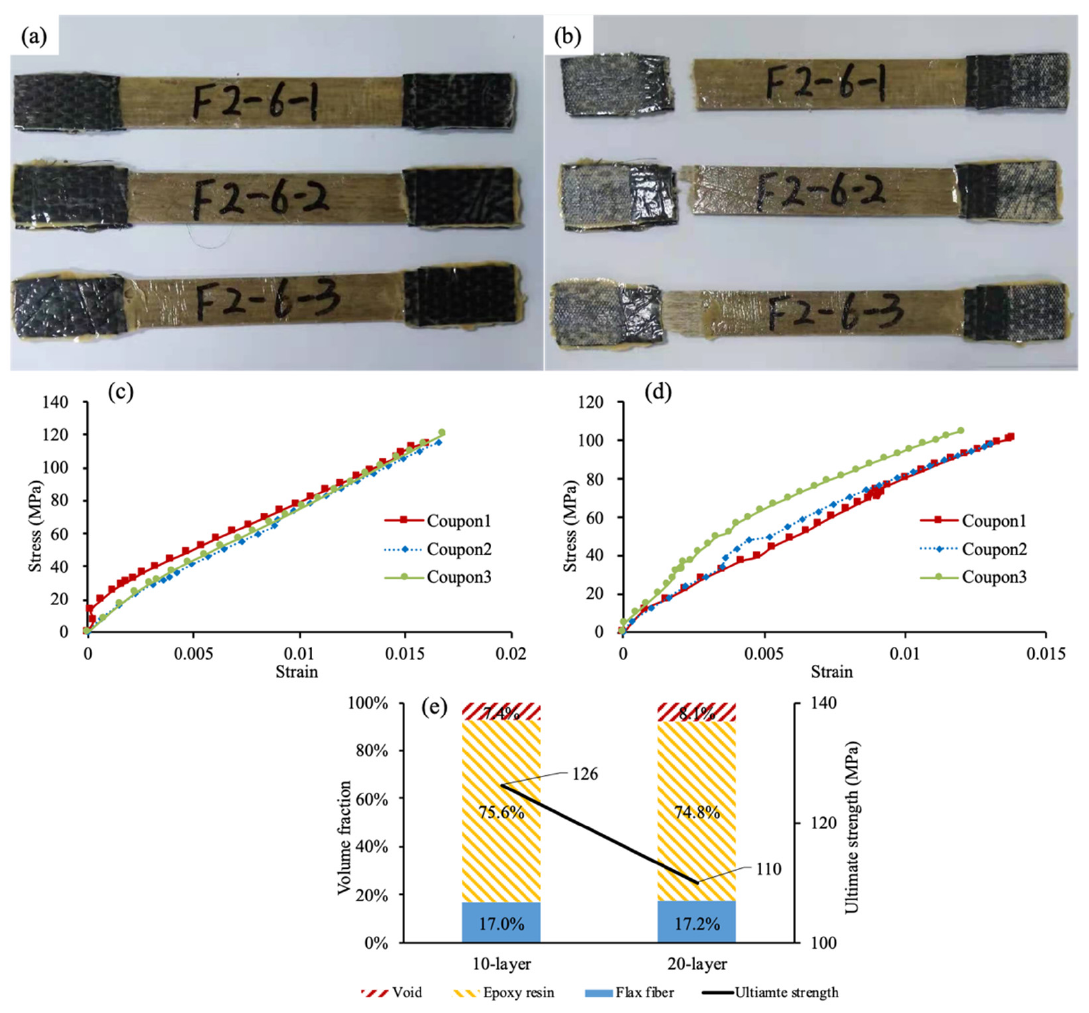
Figure 4. FFRP material properties: ( a ) coupon specimen; ( b ) coupon rupture; ( c ) stress–strain relation (10-layer); ( d ) stress–strain relation (20-layer); and ( e ) summary.